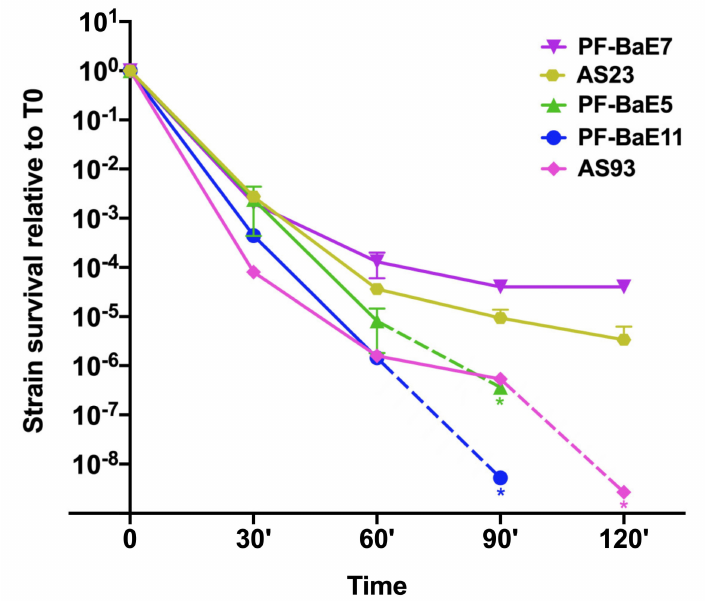
Figure 3. Relative survival of selected strains to the simulated gastric fluid over 2 h. Results are expressed as the ratio of the CFU / mL at a given time point to the CFU / mL at time zero ± SEM with a semi-logarithmic scale. * indicates a default value corresponding to a number of CFU / mL below 100 (as the CFU / mL at T0 was slightly di ff erent among strains, the default values di ff er). Dotted lines are joining the last CFU measures and default